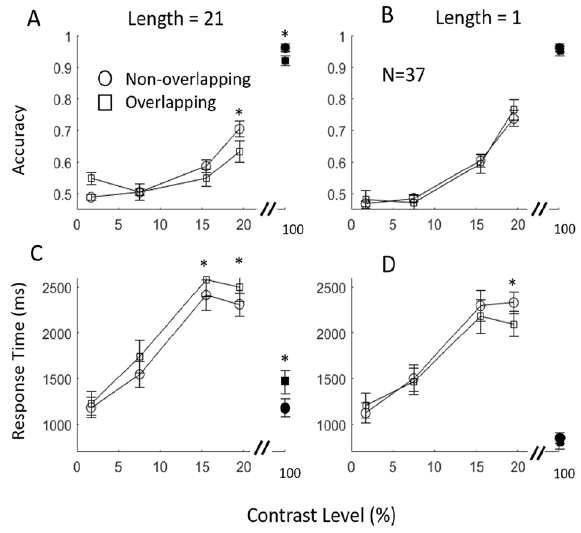
Figure 3. Accuracy ( A , B ) and response time ( C , D ) results (open symbols) with standard error. Participants’ responses for a search display with a long distractor column ( A , C ) indicated a search impairment at